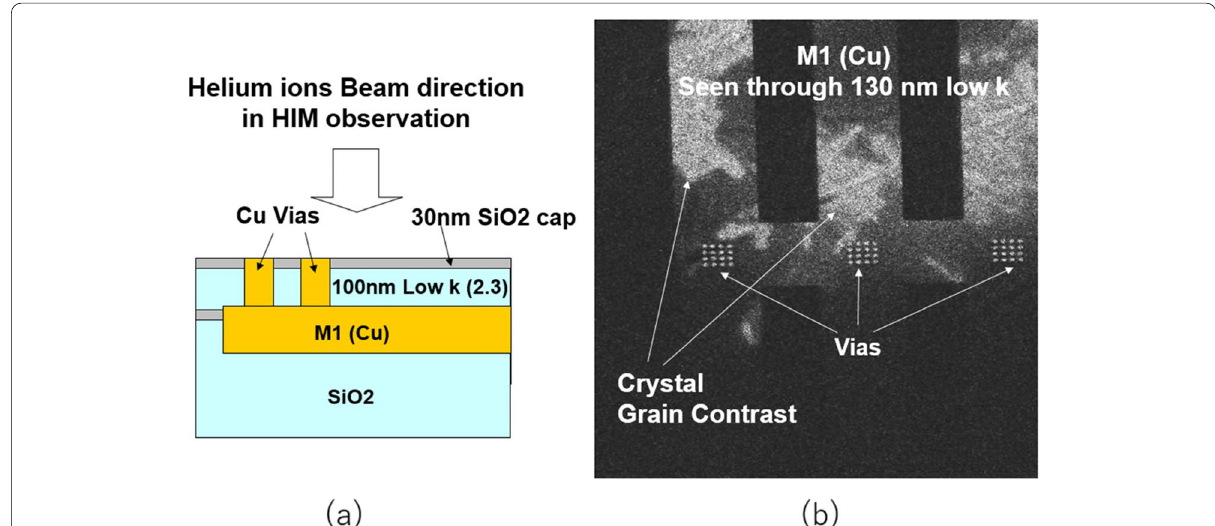
Fig. 4 a Cross-sectional diagram of the Cu metal/low-k film structure that was observed and b a HIM image of the buried M1 metal acquired from the top of the sample through the 130-nm-thick insulating film. The crystal contrast in the Cu interconnect region can likely be ascribed to channeling of helium ions. Figure modified from